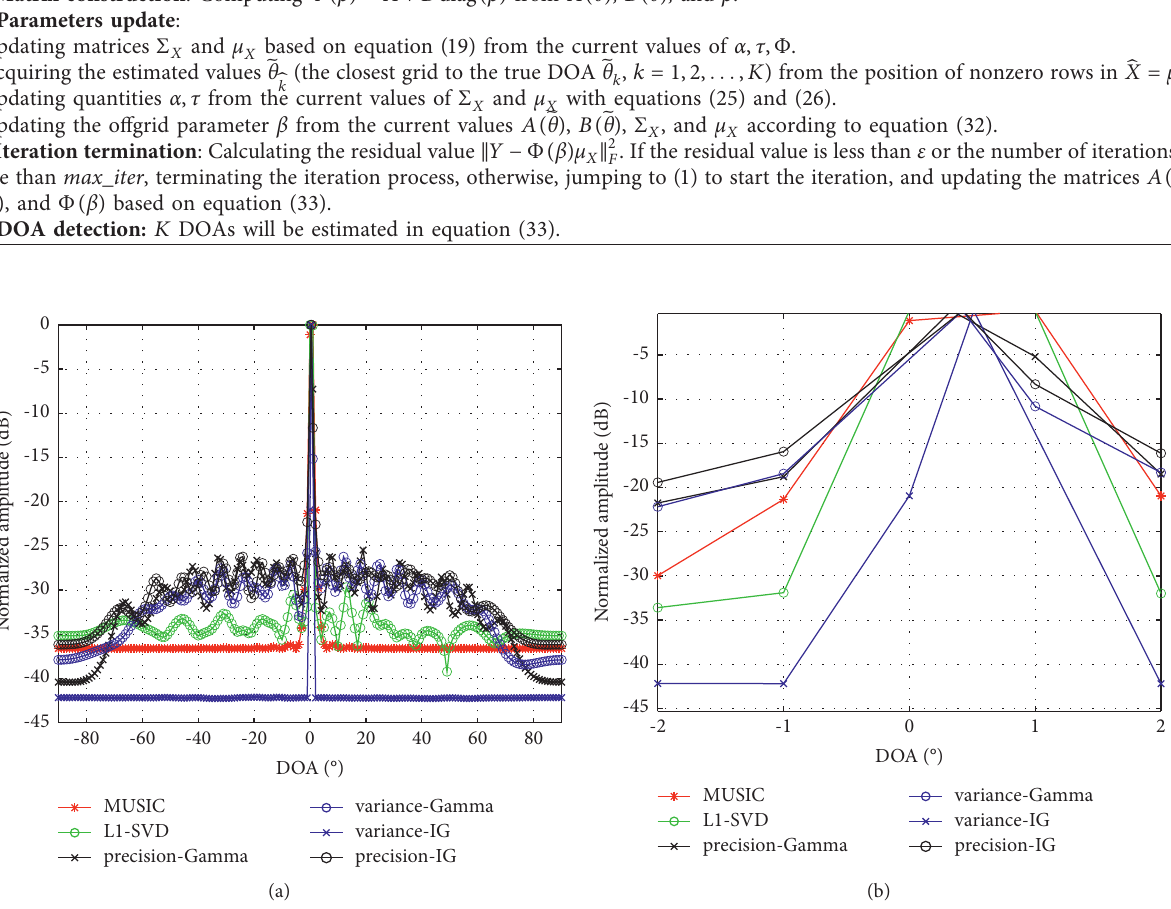
Figure 4: Single source of DOA estimation results: (a) single source DOA estimate and (b) single source DOA estimate